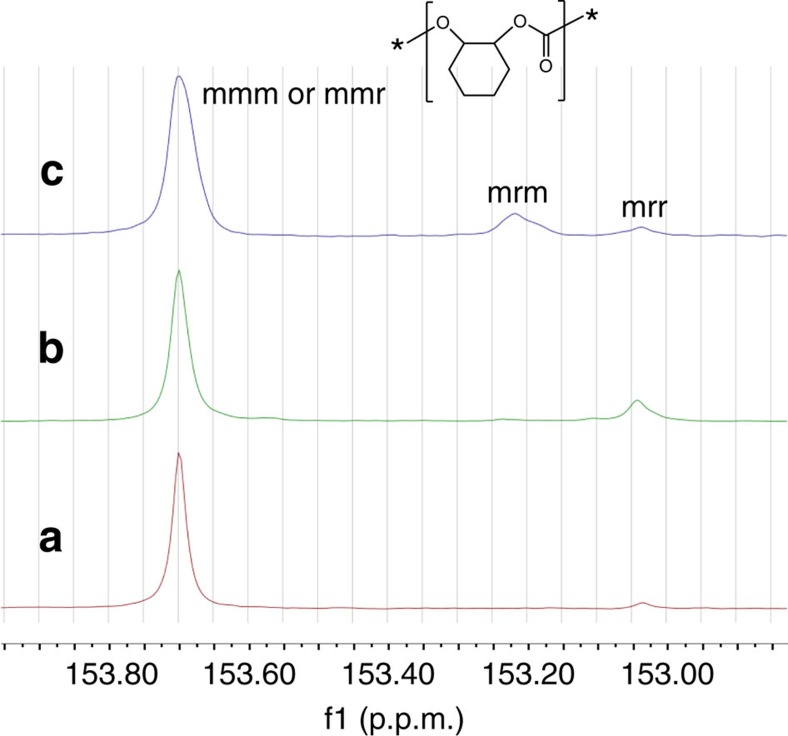
Carbonyl region of the
13C NMR spectra (125 MHz, CDCl3) of various PCHCs.(a) PCHC with 0.96 Pm catalysed by enantiopure dinuclear Co(III) catalyst in toluene27; (b) PCHC with 0.84 Pm catalysed by enantiopure dinuclear Co(III) catalyst27; (c) PCHC with 0.82 Pm catalysed by catalyst rac-1/PPN–DNP (Table 1, entry 7).